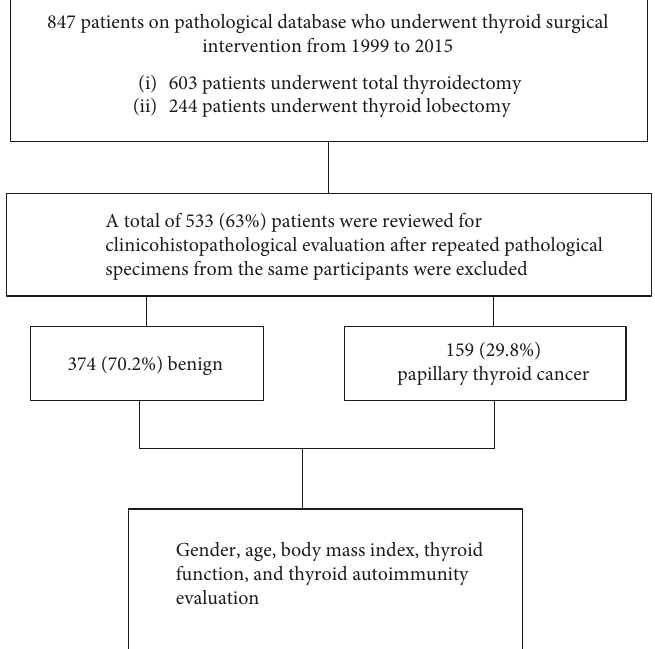
Figure 1: Schematic diagram of the study sample showing how the samples were collected and selected for